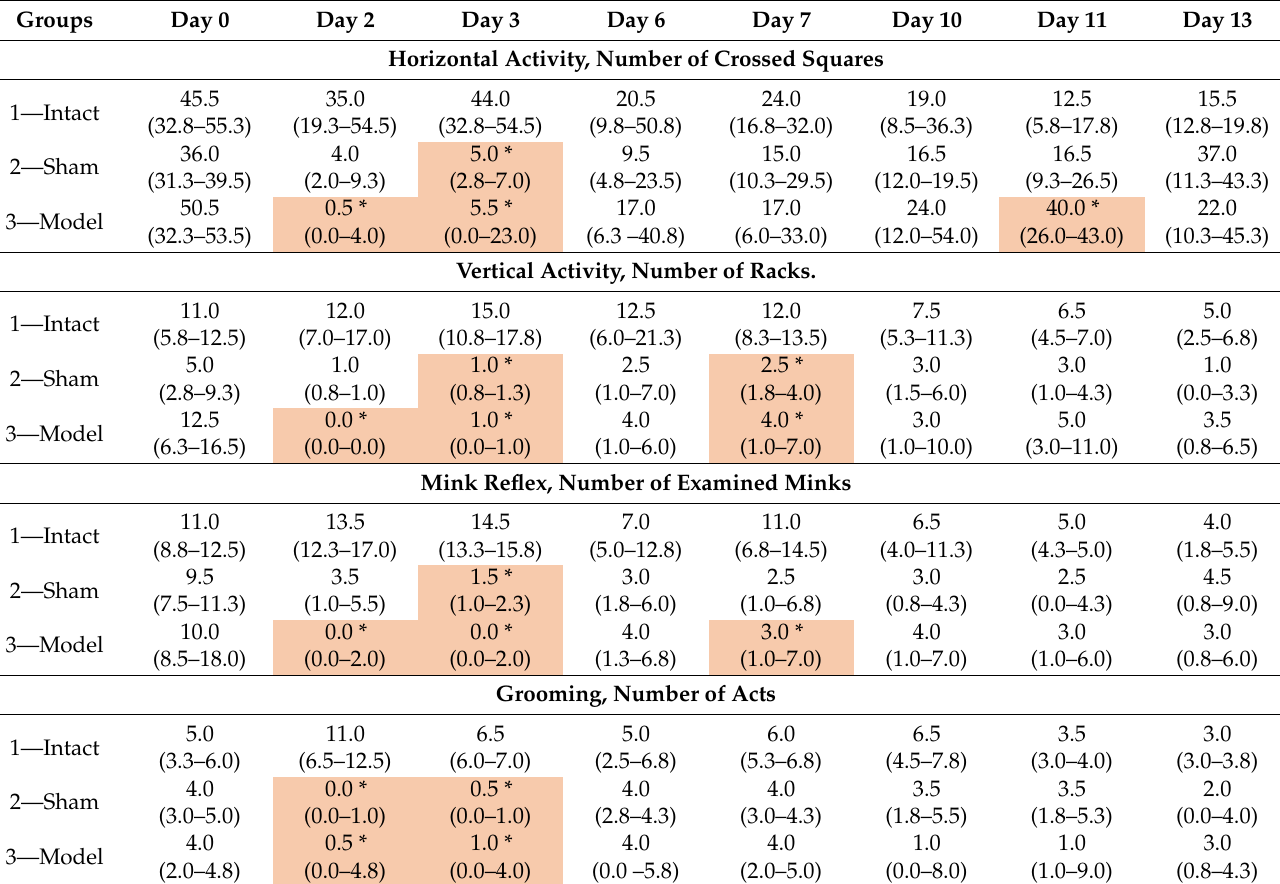
Table 4. Motor activity and orientation–exploratory behavior of rats in the “Open field” test. The results are presented as Me, (P 25 –P 75 ). In the table, colored cells allow to focus on the most important